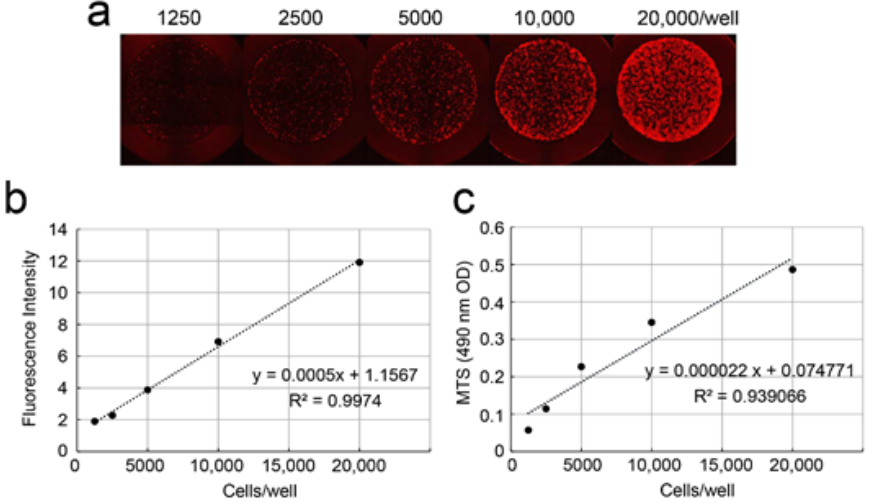
Figure 3. Correlation of fluorescence intensity and the cell proliferation rate with the cell density of DsRed-PPU7 cells. ( a ) Fluorescence microscope image of DsRed-PPU7 cells seeded on a 96-well plate at a density of 1250, 2500, 5000, 10,000 and 20,000 cells / well. ( b ) Regression line showing the correlation of the fluorescence intensity with cell density. ( c ) Regression line showing the correlation of cell proliferation with cell density by MTS